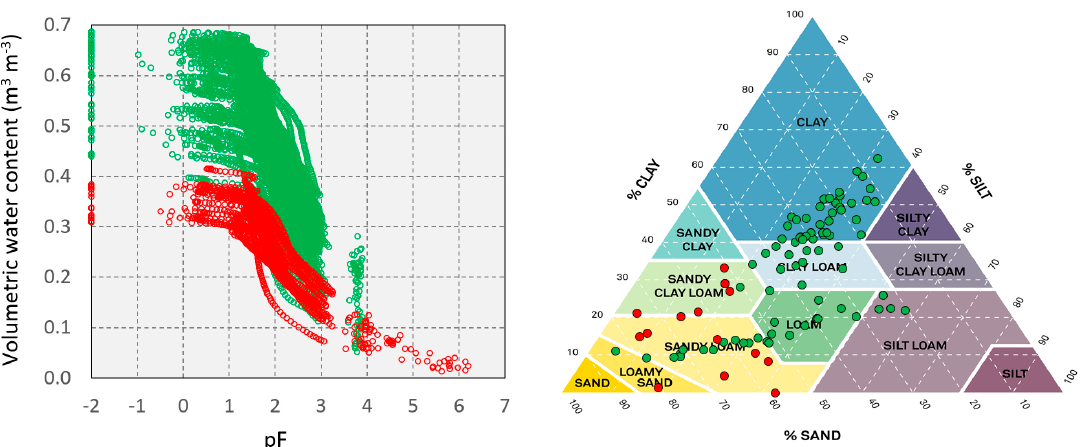
Figure 3. Soil water retention data pairs measured by the HYPROP and WP4C ( left ) and soil textural classes ( right ) where green and red represent Turkish and USA samples, respectively.